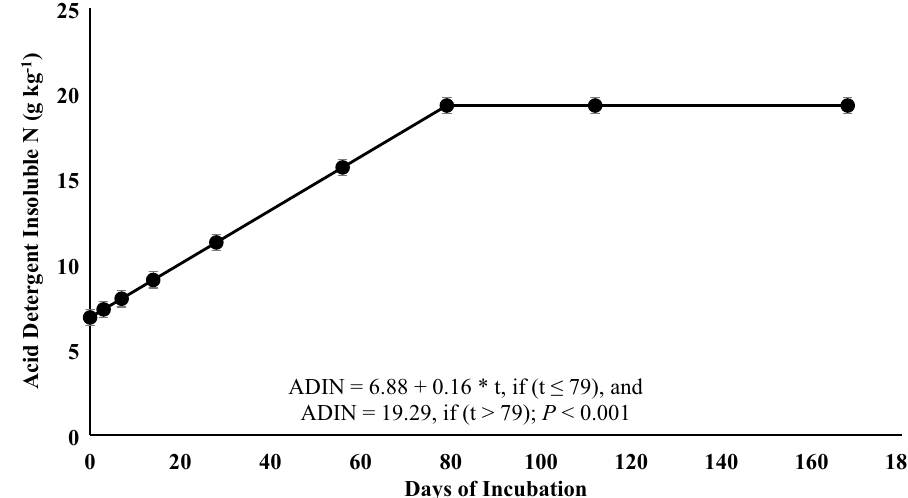
Figure 4. Acid detergent insoluble N of rhizoma peanut roots and rhizomes during a 168-days incubation period. The values represent the averages of two treatments (grazed and non-grazed) and 2 years. Bars refer to the SE.